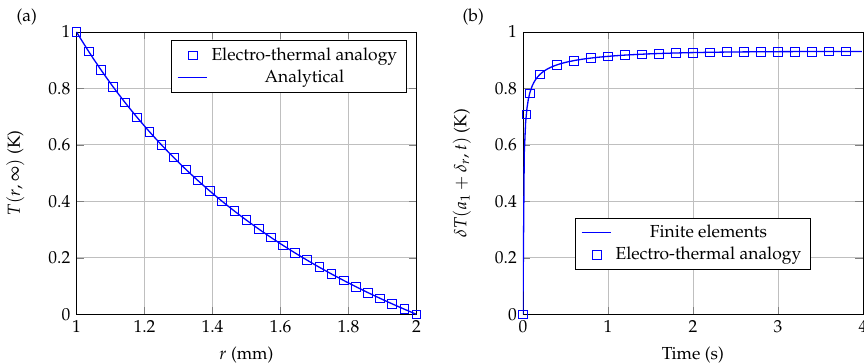
Figure 10. Electro-thermal modeling of bioheat transfer through a shell subjected to Dirichlet boundary conditions and constant heat volumetric source. ( a ) Steady state temperature profile through the shell. ( b ) Temperature variations as a function of time at r = a 1 + δ r .